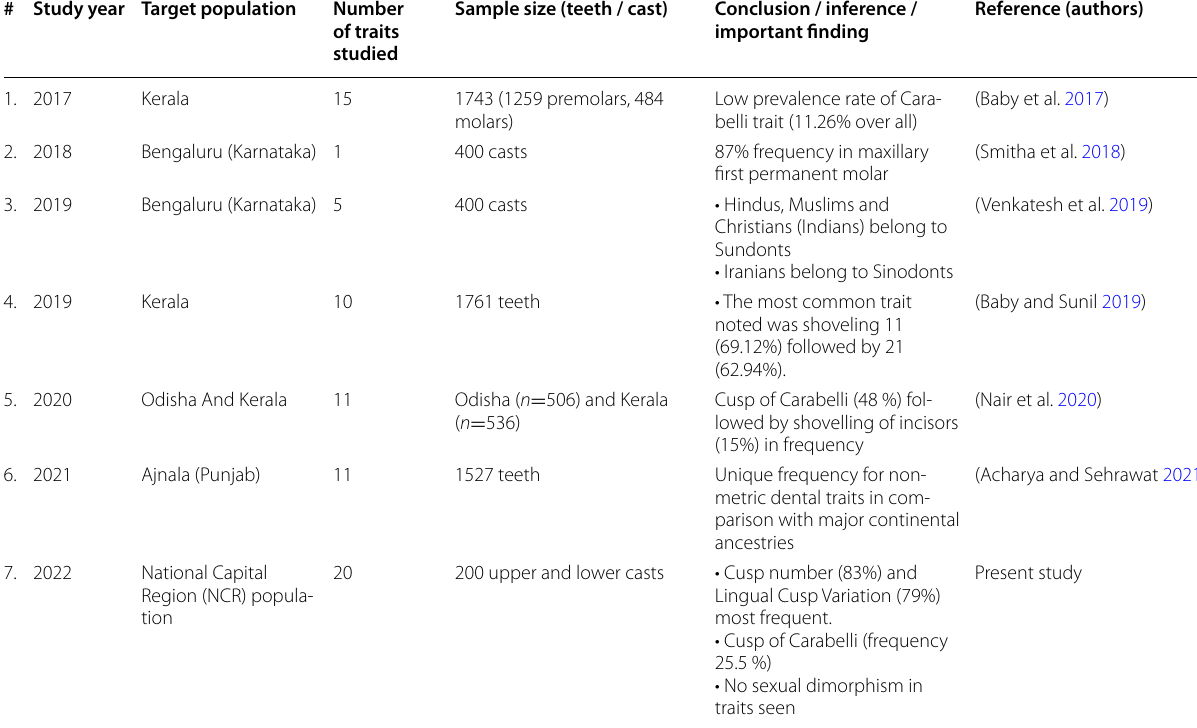
Table 6 Comparative analysis table of various ASUDAS-based Indian studies